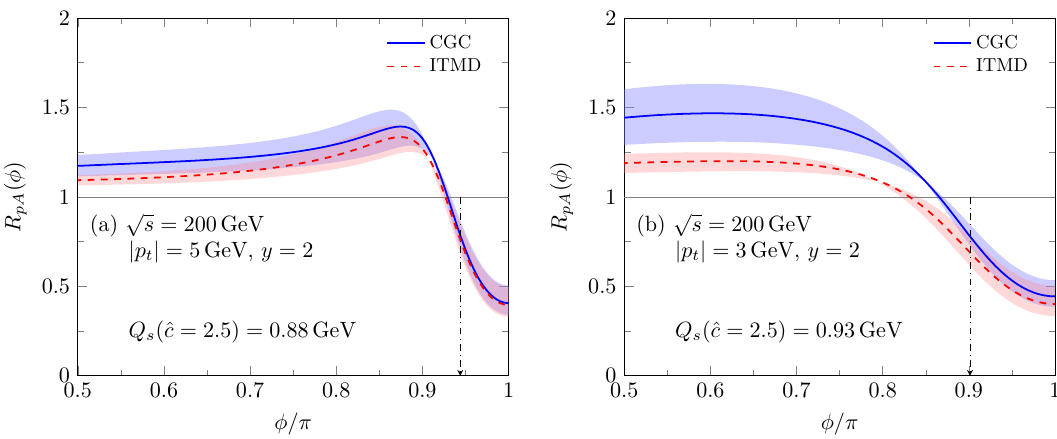
Figure 11 . Nuclear modification factor as a function of φ for forward dijet production of | p t | = √ 5 GeV (a) and 3 GeV at s = 200 GeV. Notation is the same in figure 10.